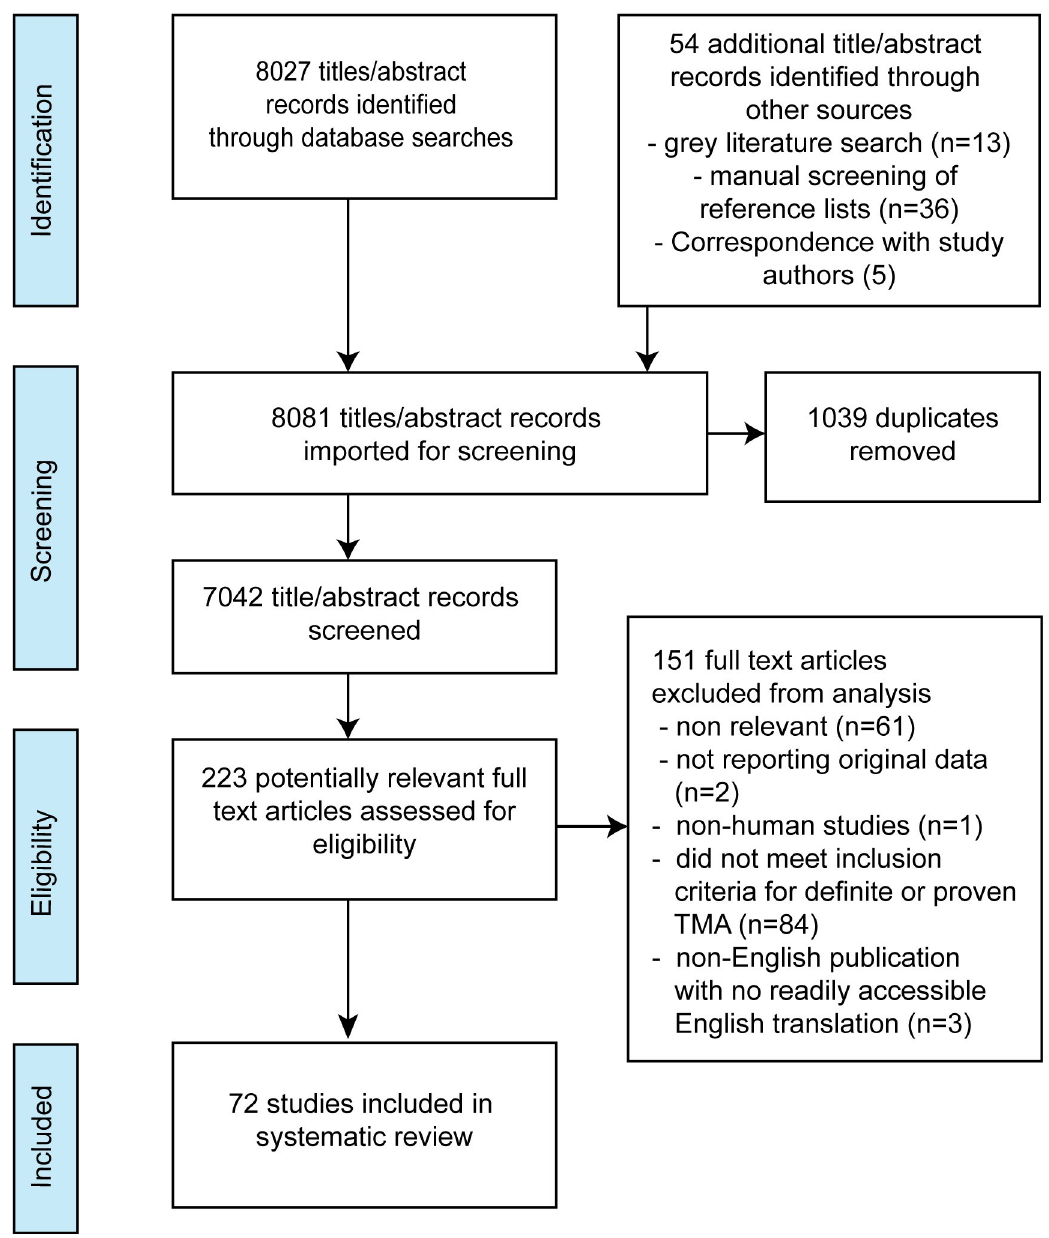
Fig 1. Study selection PRISMA study flow diagram derived from Moher D et al [29].